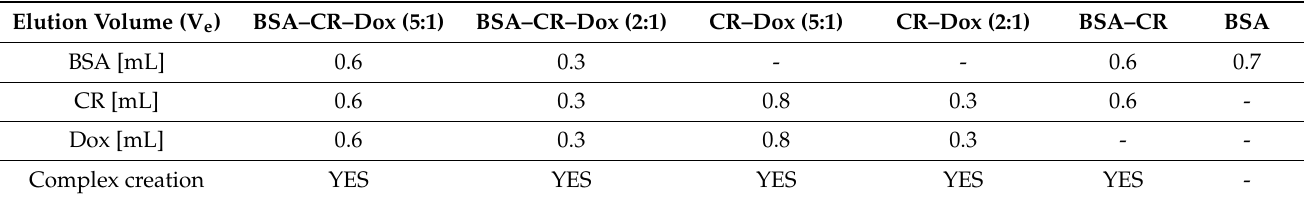
Table 1. Gel–filtration chromatography: elution volume (V e ) of BSA, CR, and Dox in mixtures of BSA–CR–Dox, CR–Dox, BSA–CR (1:10), and in free BSA (Biogel P–300). The molar ratios of